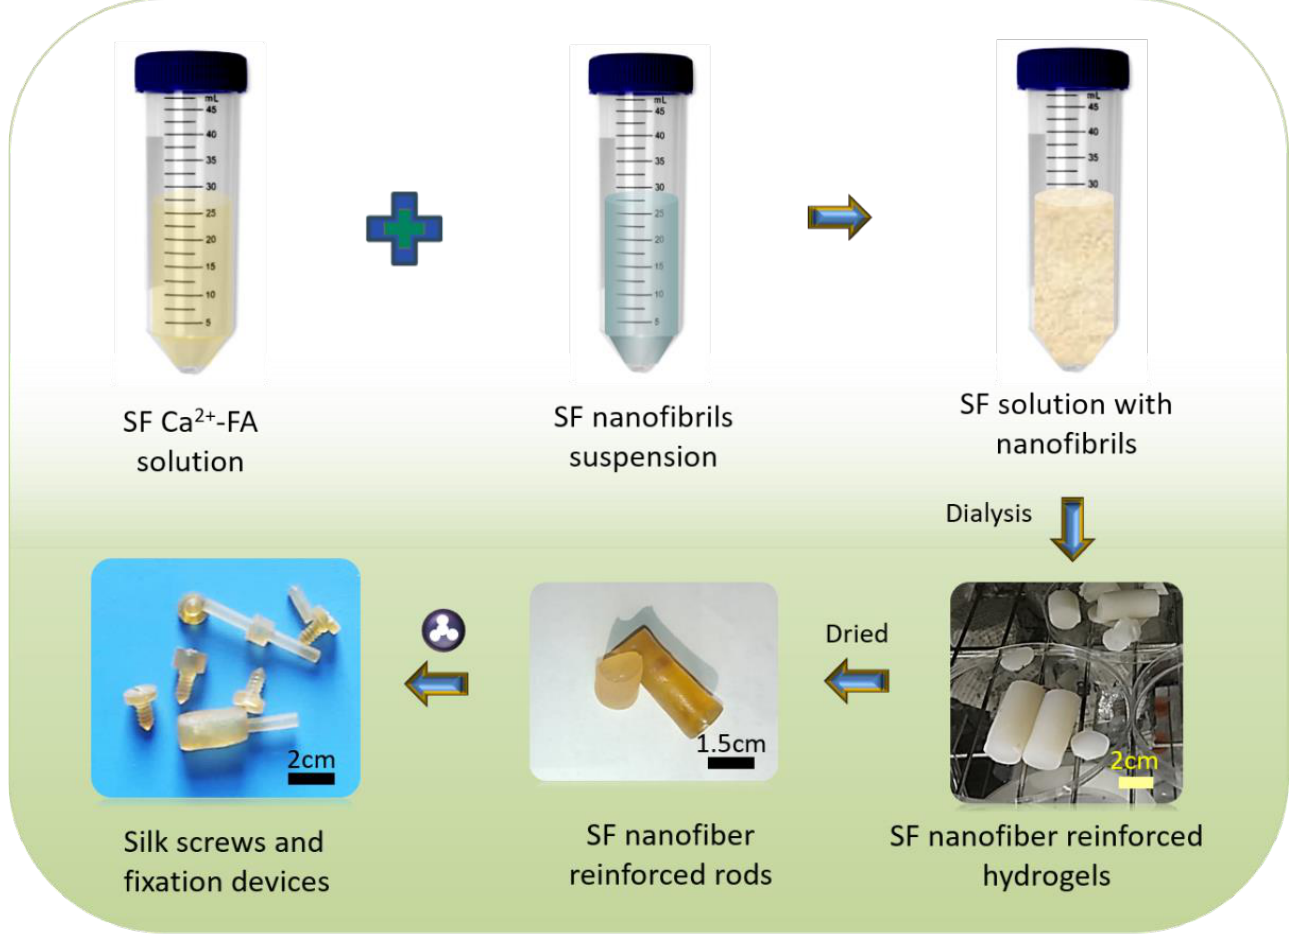
Figure 3. Schematic illustration of the silk screw fabrication process. The process could be divided into six steps. It is simple and easy-handle. The degummed silk fibers were directly dissolved intoCa 2+ -FA solution. The natural SNFs were mixed with the silk Ca 2+ -FA solution. The mixture was placed into dialysis tubes and dialyzed to form silk hydrogels. The hydrogels were dried in an oven to obtain silk rods. After milling, the silk rods were processed into silk screws. The increase in SNF percentage decreased the transparency of silk